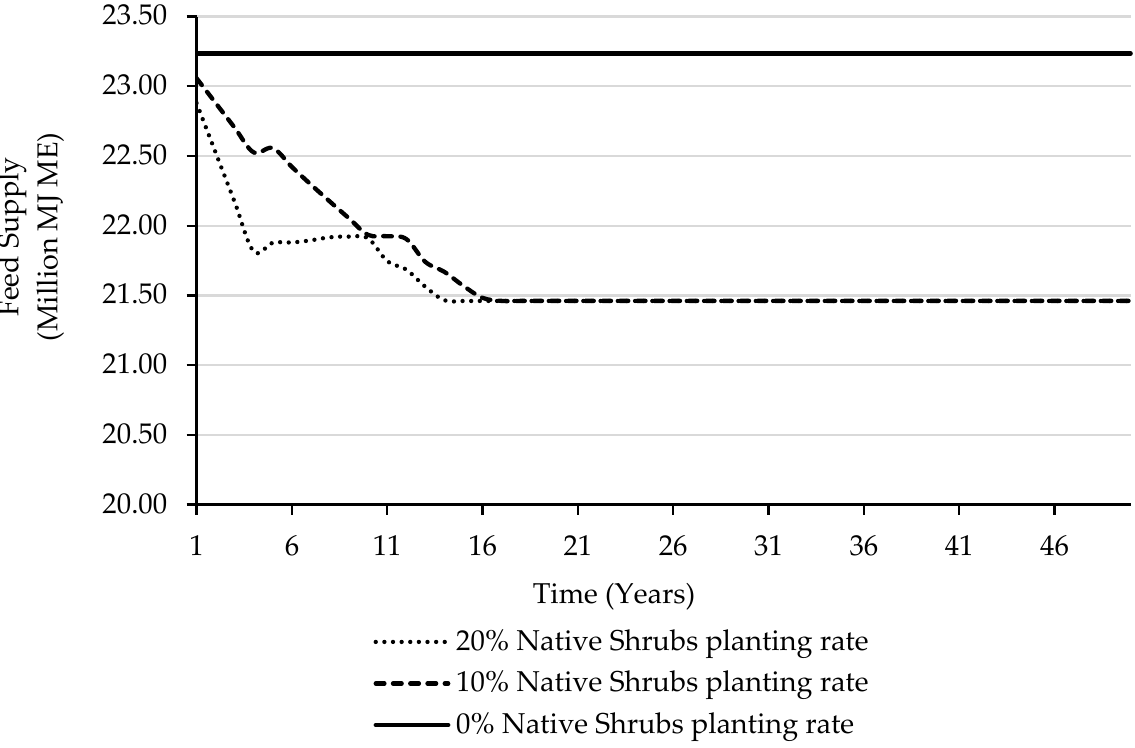
Figure 2. Annual feed supply for 50 years in metabolizable energy (million megajoules) with native shrubs planted on 10% the modelled farm at three planting rates (0%, 10%, and 20% per year).